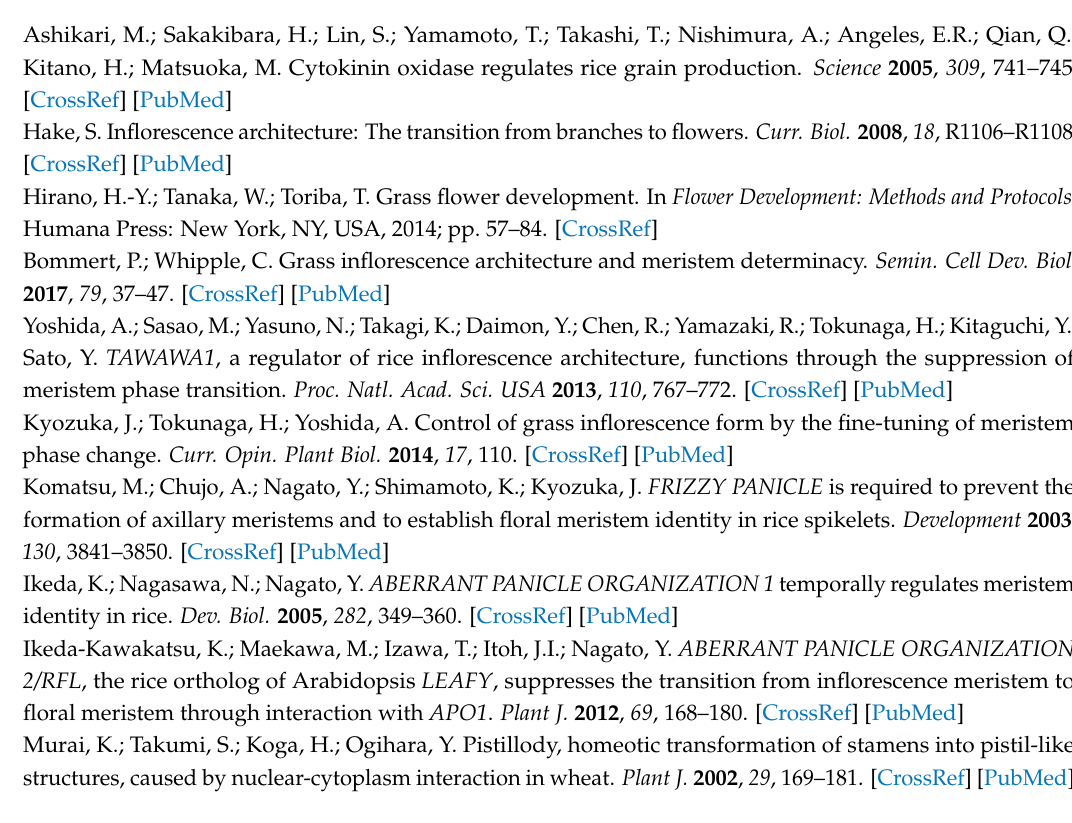
Supplementary Materials: Figure S1: Cloned promoters of TtALOG genes involved in BM development, Table S1: Primers used in this study, Table S2: The primary sequence features of identified ALOG homologs, Table S3: Classification of cis-regulatory